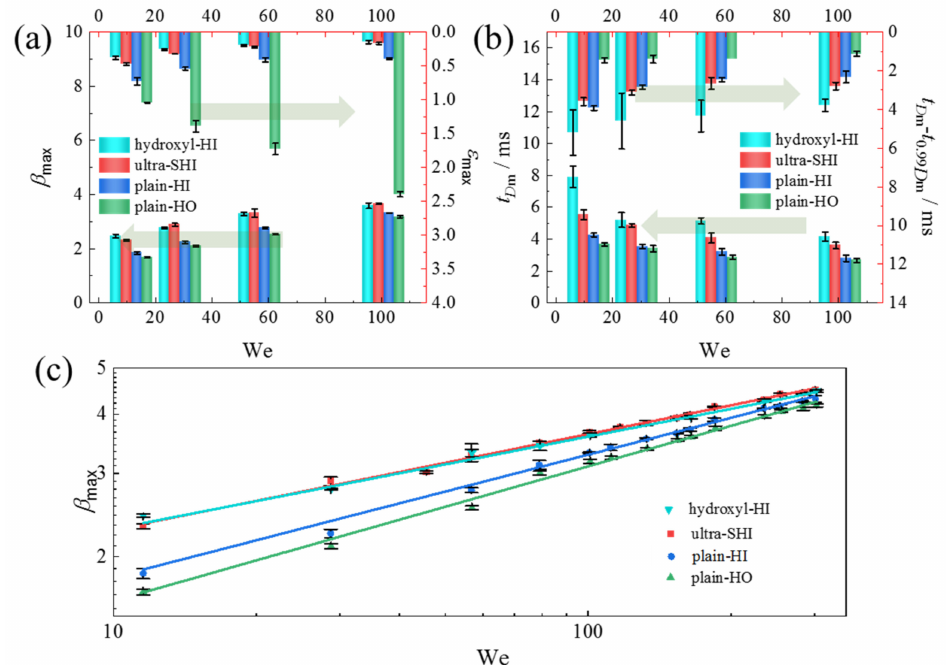
Figure 6. Effect of the We number on the spreading characteristics of the droplet impact. ( a ) Maximum spreading factor β max and maximum dimensionless recoiling height ε max as a function of the We number on the test surfaces. ( b ) Inertia time required to reach the maximum spreading diameter t D m and the time interval during which the maximum spreading diameter t D m – t 0.99 D m was maintained as a function of the We number on the test surfaces. ( c ) Variation in the maximum spreading factor β max as a function of the We number on the test